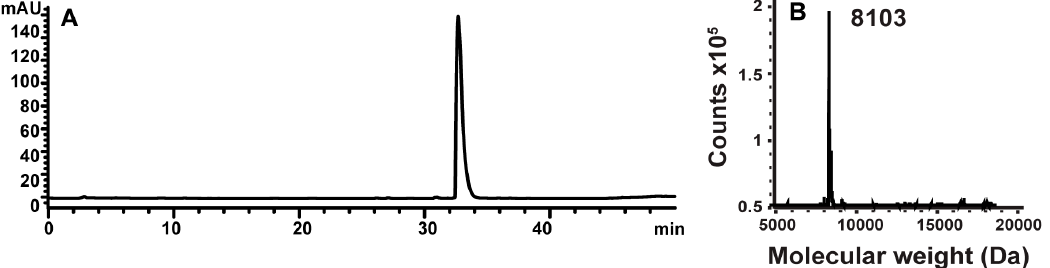
Figure 2. ( A ) HPLC chromatogram ( B ) mass spectrum of DFO ‐ ZEGFR:2377 conjugate. Expected mass is 8102.8 Da.